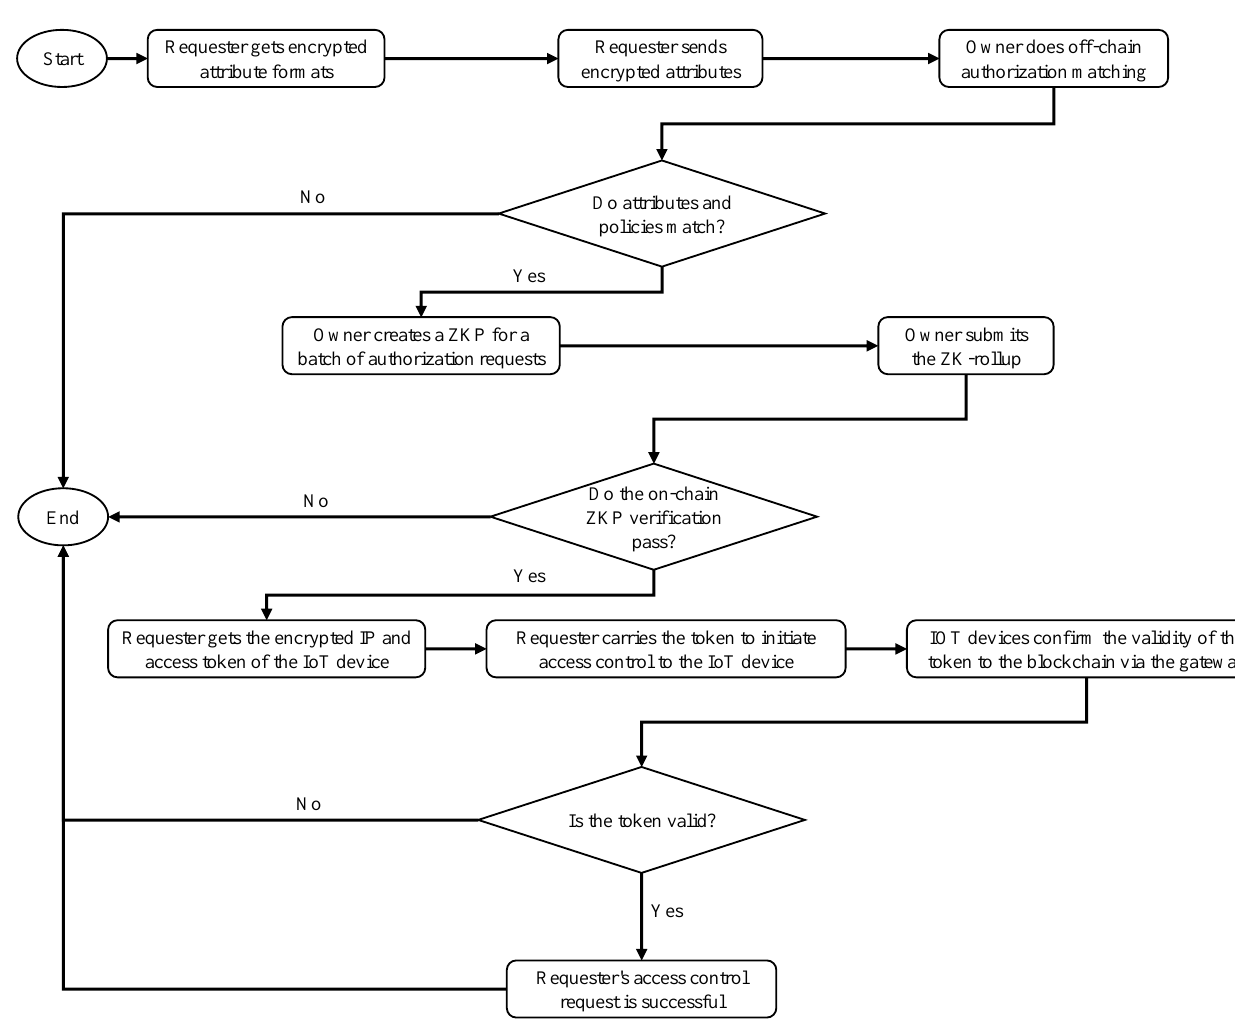
Figure 2. Flow diagram of a sample access